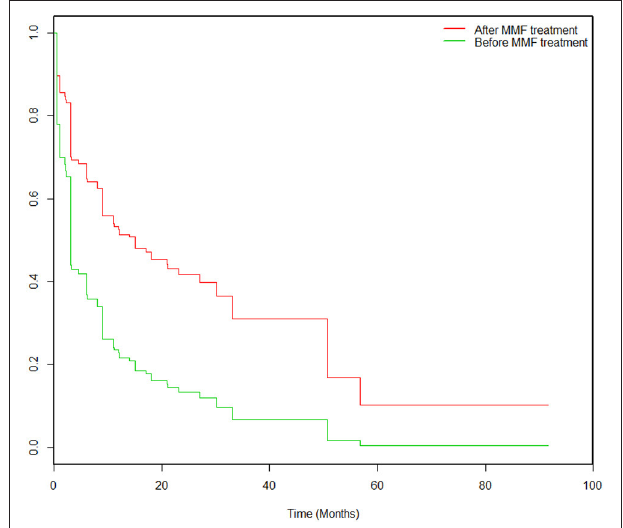
FIGURE 3 | Kaplan-Meier survival analysis pertaining to the probabilities of adverse events pre-MMF and post-MMF in 90 patients. All patients were prescribed MMF at time 0. The incidence of adverse events decreased significantly after MMF administration compared to that before MMF treatment (HR = 0.434, 95% CI: 0.202–0.933; P =